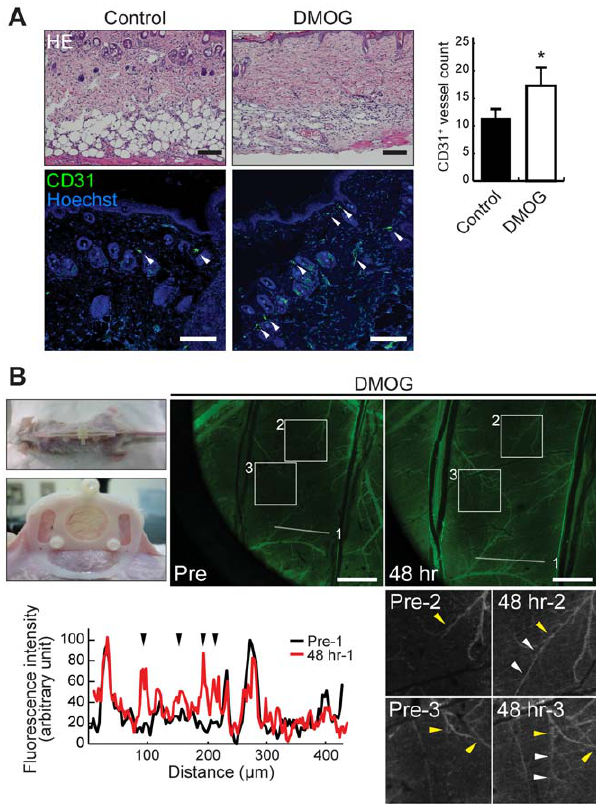
Figure 2. Effects of DMOG treatment on postoperative angiogenesis and vasculature in mouse subdermal plexus. A, Sections of proximal parts of the skin flaps near the pedicles were stained with hematoxylin and eosin (HE) and with anti-CD31 antibody (arrowheads). To evaluate the effect of DMOG on the neovascularization in the proximal part of the flap, the number of CD31-positive (green) vessels was counted and is indicated as vessel density per high-power field. Scale bar indicates 200 m m. B, Intravital microscopic analysis of the vasculature of the subdermal plexus in DMOG-treated mice. After the intraperitoneal injection of DMOG, the subdermal plexus visualized by intravenous injection of FITC-dextran was observed in the dorsal skin- fold chamber by fluorescence microscope. Fluorescent intensity at cross-section of the line 1 showed that the number of detectable vessels was increased 48 hours after DMOG treatment, compared to the untreated control (Indicators of arrowheads in the graph represent the detectable vessels). Magnified images of square frame line 2 and 3 showed that vasodilation of preexisting vessels observed in the border zone of the vascular territory. Yellow arrowheads indicate the relative locations in the vasculature as the landmarks, and white arrowheads the detectable vessels in the border zone of the vascular territory 48 hours after DMOG treatment. Scale bar indicates 250 m m.